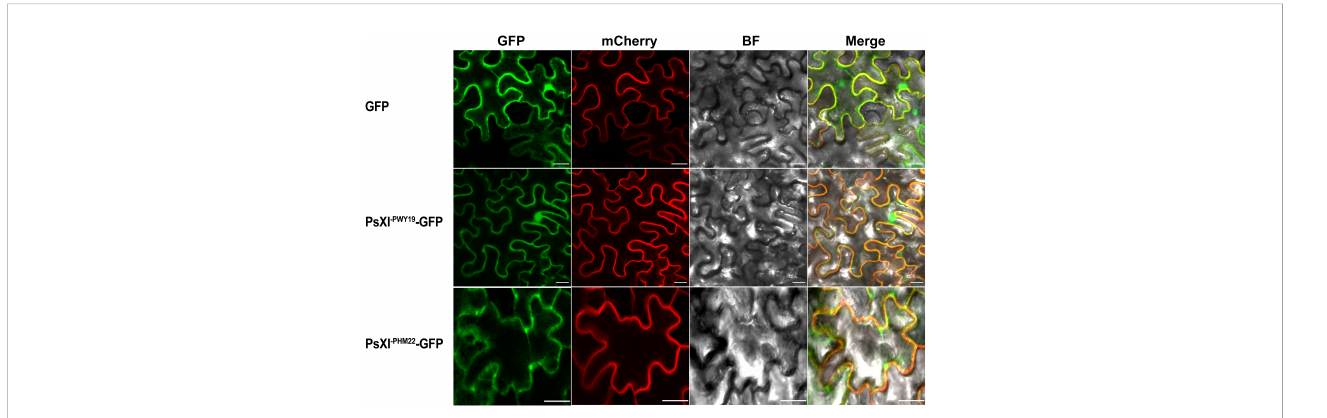
FIGURE 8 Subcellular localization of PsXI-GFP fusion proteins. GFP was used as a control. mCherry channel acts as a marker of the plasma membrane. BF, bright fi eld. Scale bars, 20 m